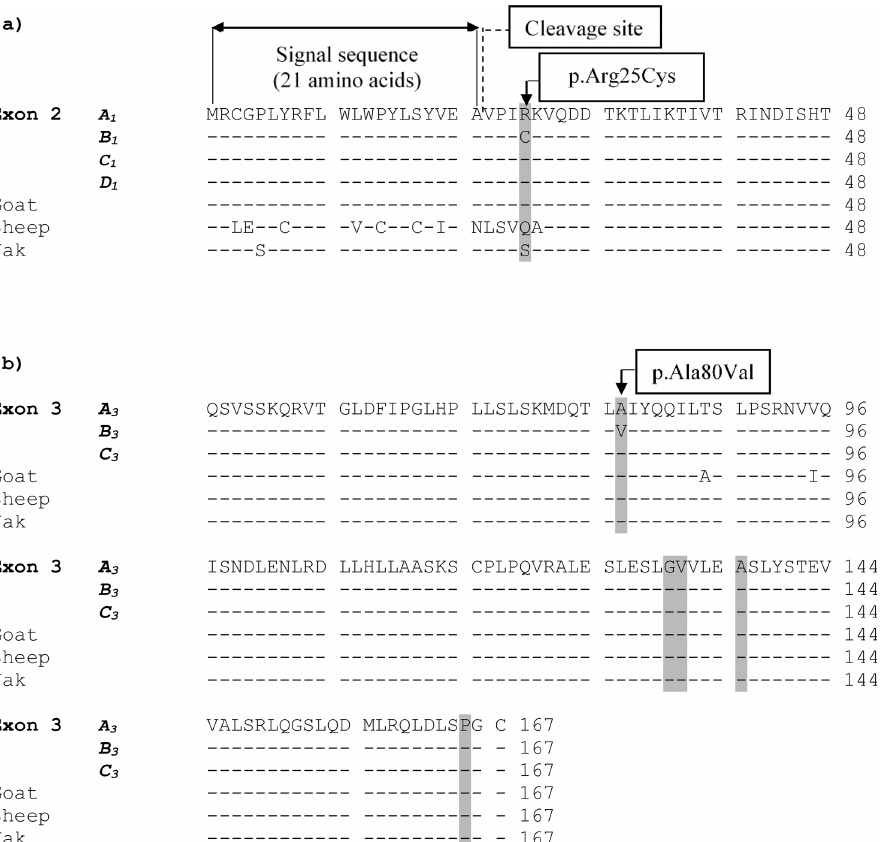
Figure 3. (a) An alignment of the predicted amino acid sequence of leptin protein obtained from the four variants ( A 1 , B 1 , C 1 , and D 1 ) identified in exon 2. The grey highlighted areas mark the position of the amino acid difference between the variant sequences and other species. (b) Alignment of the putative amino acid sequence of leptin protein from the three variants ( A 3 , B 3 , and C 3 ) in exon 3 and from sequences in other species. The grey highlighted areas mark the position of amino acids where the underlying nucleotide sequence is variable. The symbol “–” represents the same amino acid as the top (reference sequence). The amino acid sequence for cow was obtained from the coding sequences examined in this study, whereas the others were obtained from GenBank JQ739233.1 (goat), MH716186.1 (sheep), and EU603265.1